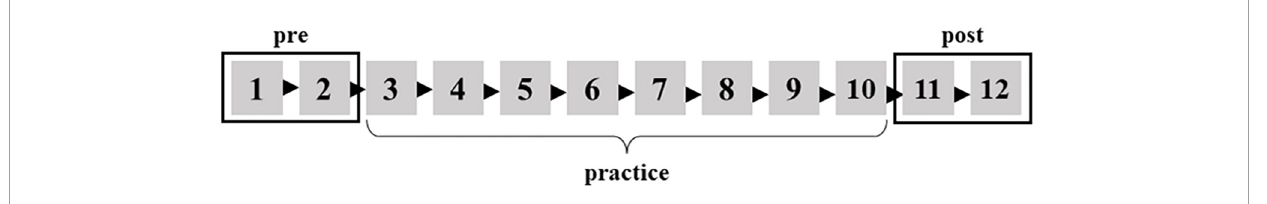
FIGURE1 The BR task was carried out 12 sets in total. The mean of the first two sets is defined as pre. The mean of the last two sets is defined as post.